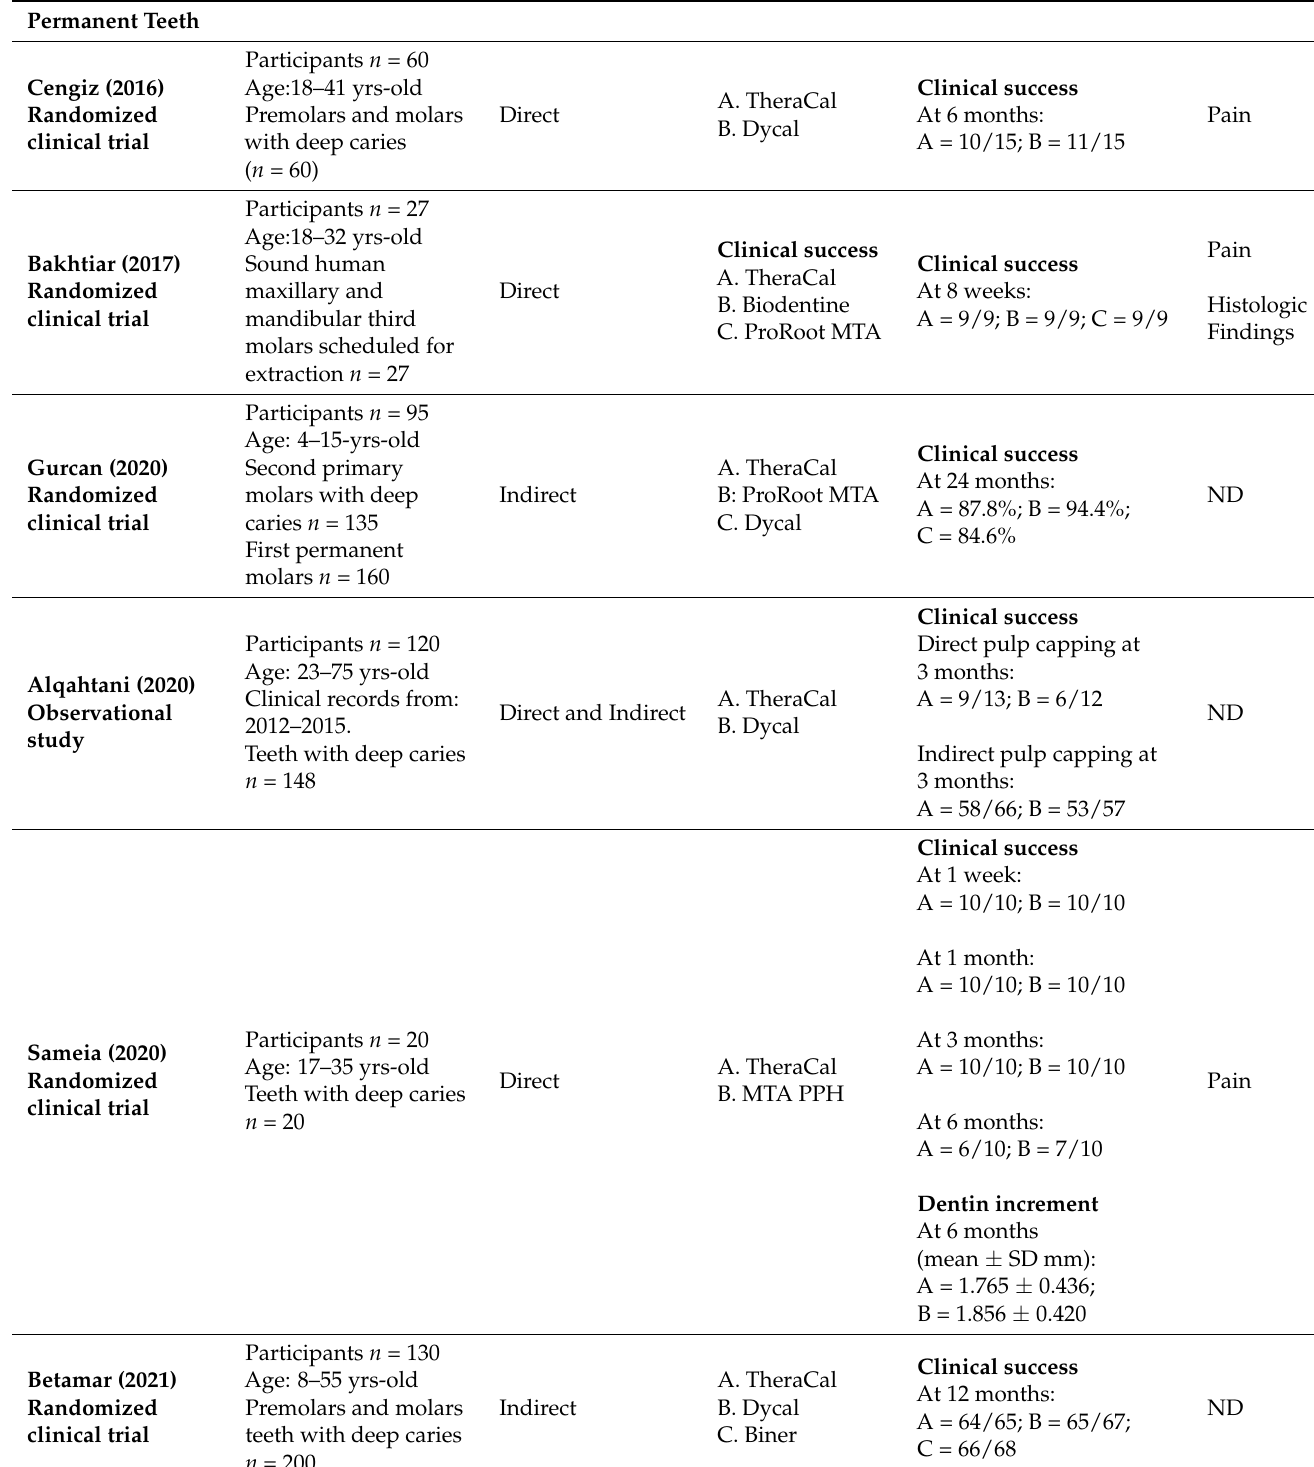
Table 4. Characteristics of the individual studies and their